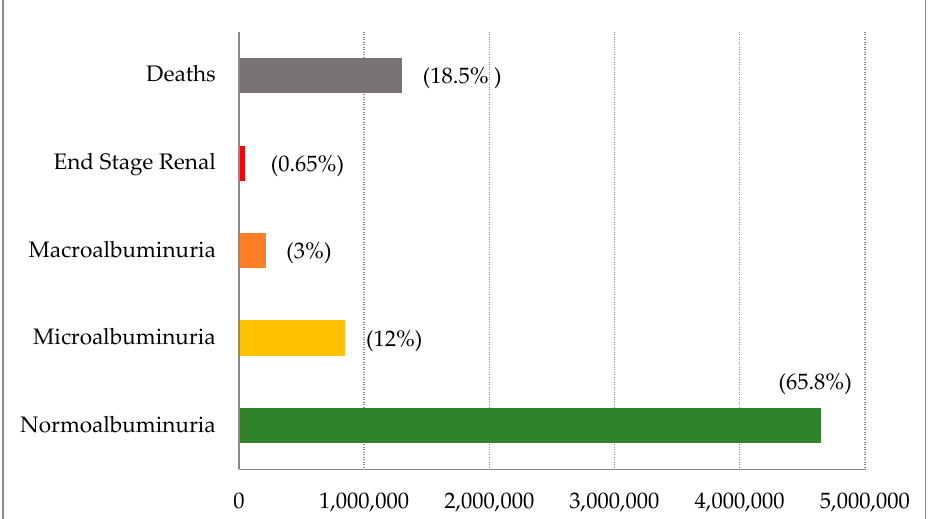
Figure 2. Distributions of CKD stages secondary to T2 DM, 2022.